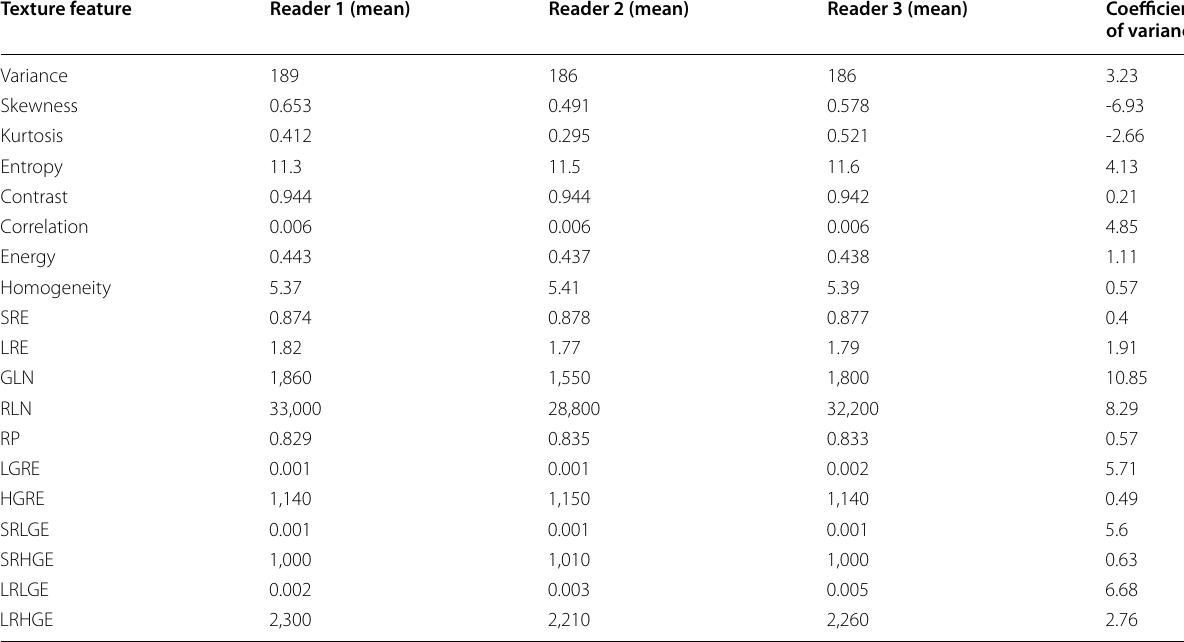
GLN Grey-level nonuniformity, HGRE High grey-level run emphasis, LGRE Low grey-level run emphasis, LRE Long-run emphasis, LRHGE Long-run high-grey-level emphasis, LRLGE Long-run low-grey-level emphasis, RLN Run-length nonuniformity, RP Run-percentage, SRE Short-run emphasis, SRHGE Short-run high-grey-level emphasis, SRLGE Short-run low-grey-level